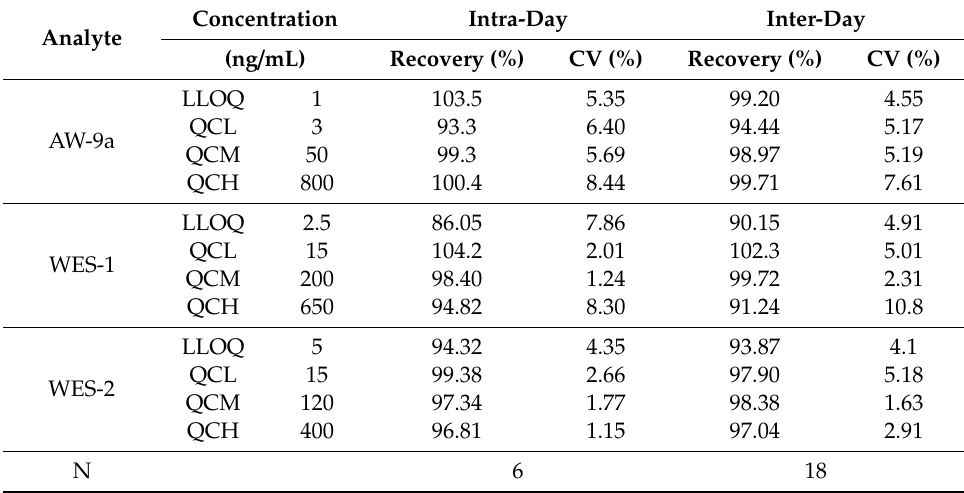
Table 2. Intra- and inter-day accuracy and precision results for AW-9a, WES-1, and WES-2